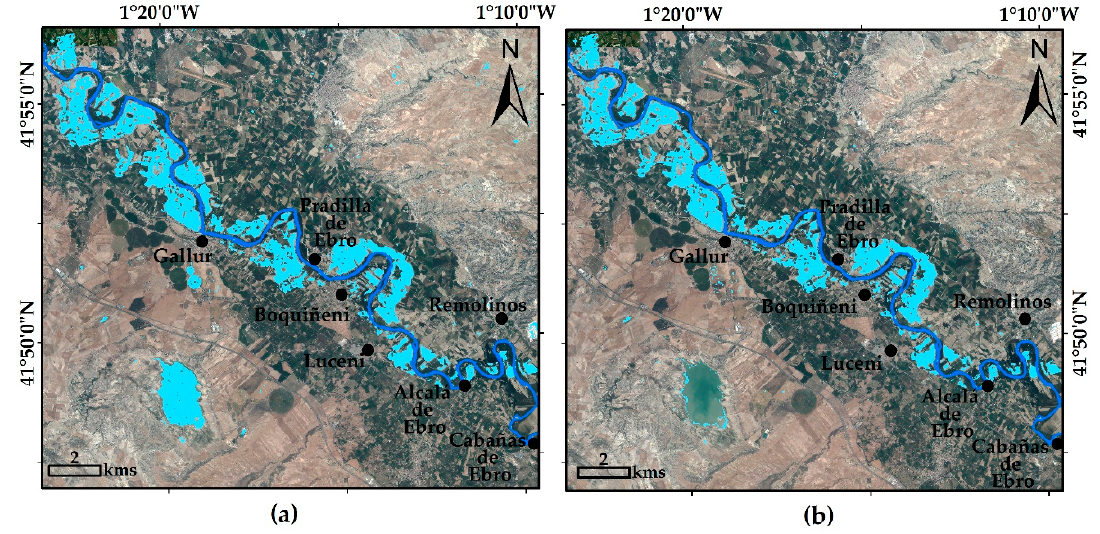
Figure 13. ( a ) Map of zone 1: Novillas–Pradilla de Ebro calculated using the calibration threshold methodology, with an intensity limit of − 21 dB. ( b ) Representative map only of the flood zones of zone 1: Novillas–Pradilla de Ebro (Source: PNOA base map).